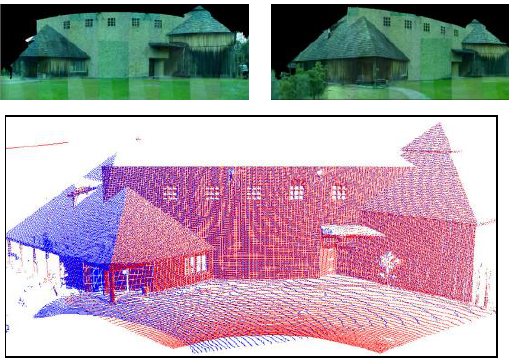
Figure 12. Images of Building C and registration result.